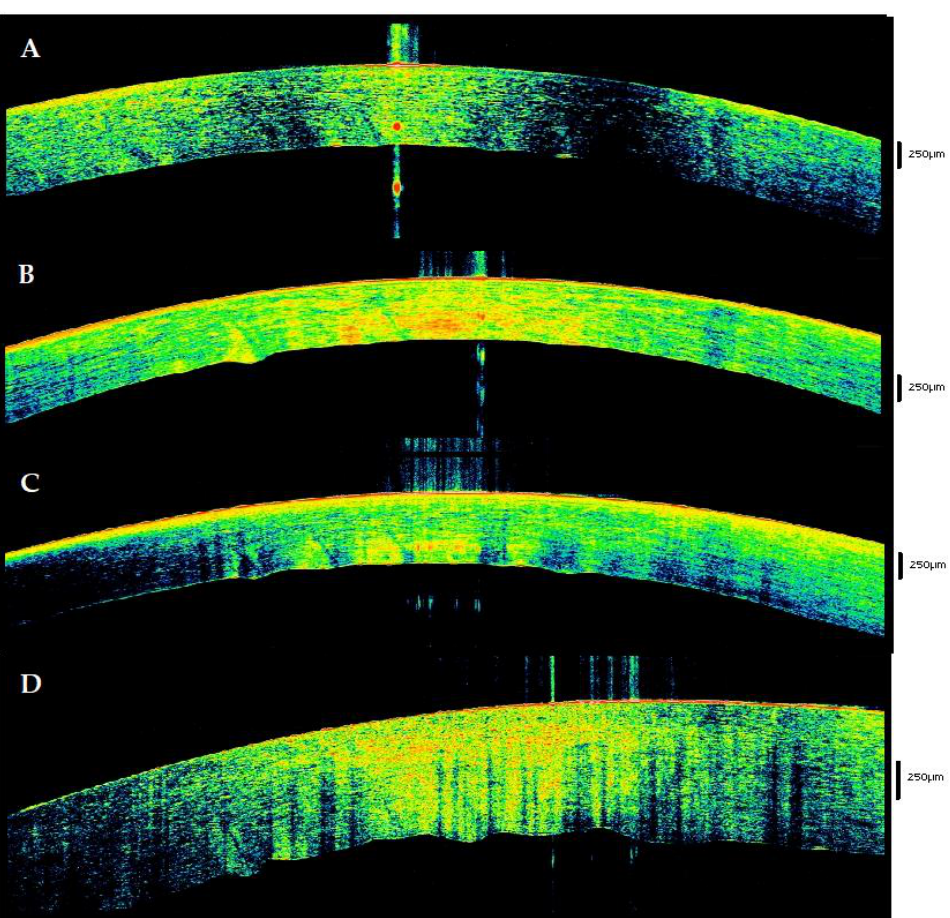
Figure 5. Nioi – Napoli sign. The Nioi – Napoli sign is a morphological feature occurring in the posterior part of the cornea in the postmortem period. This sign is likely due to two different phenomena that take place in distant portions of the cornea: the dehydration of the anterior tissues and the edema of the posterior part (which has repercussions in all contiguous tissue of the stroma, epithelium included. From the morphological point of view, it consists of different phases or stages: ( A ) “Stade I”: initial posterior waving. ( B ) “Stade II” posterior waving with 1 peak. ( C ) “Stade III” posterior waving with multiple peaks and initial stromal swelling. ( D ) “Stade IV” posterior waving and multiple peaks with extreme stomal swelling.